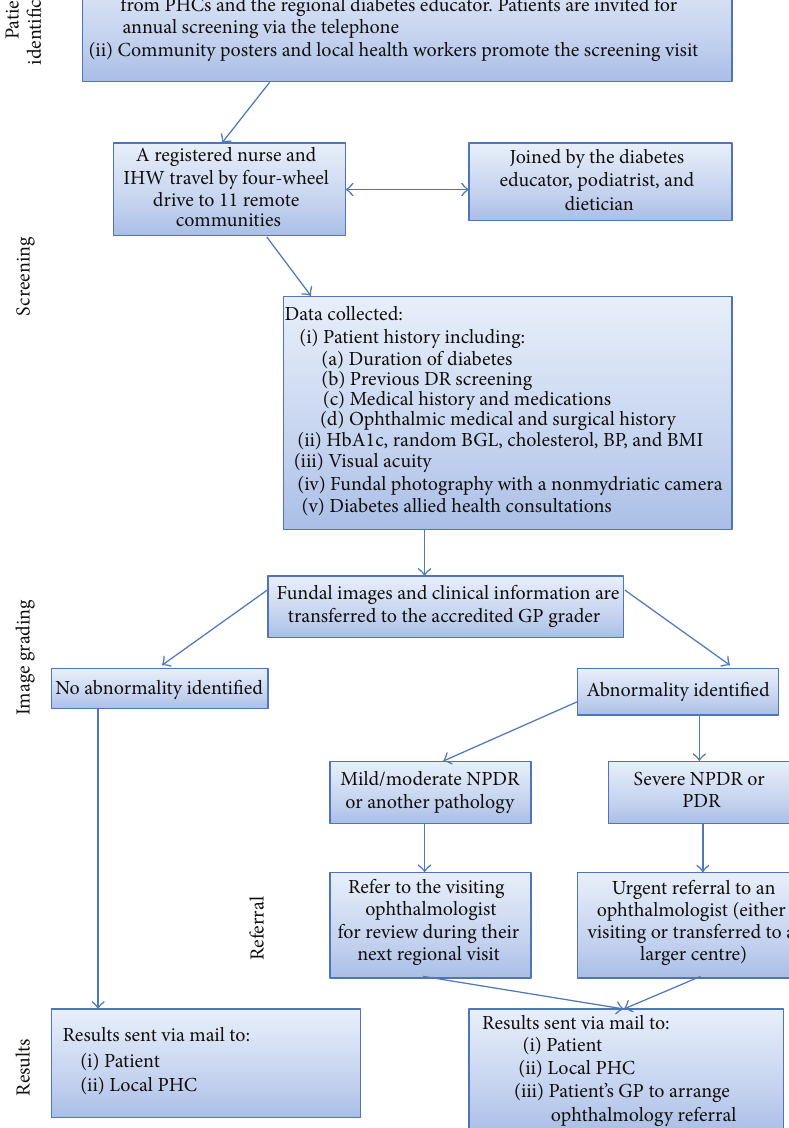
Figure 2: The remote outreach DR screening